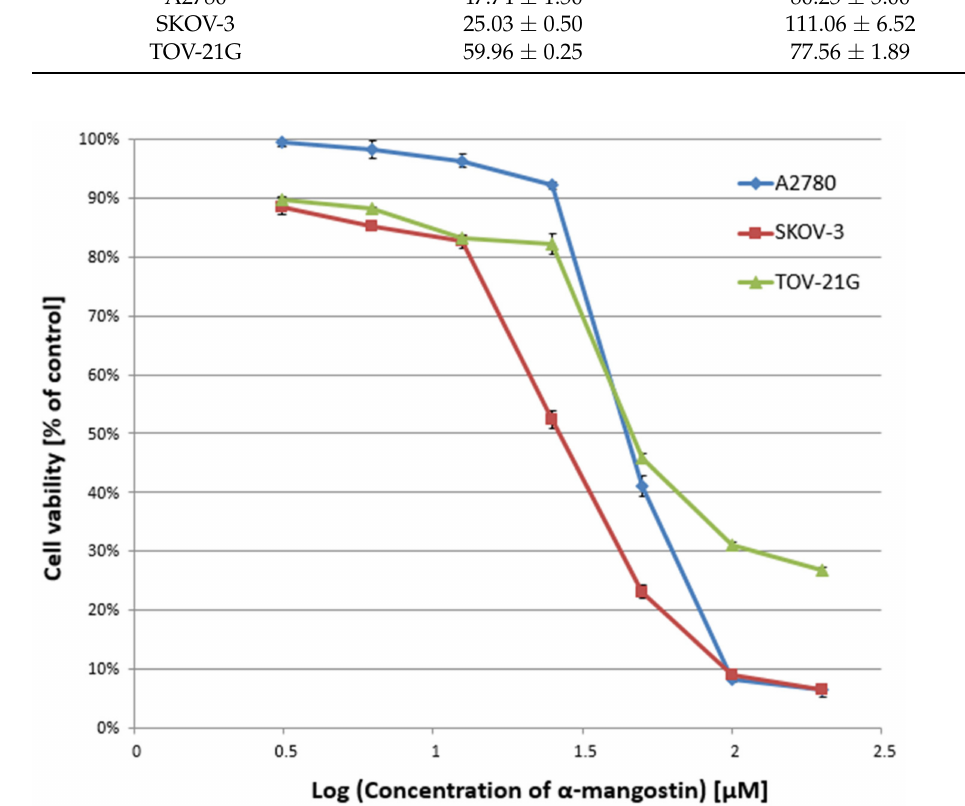
Figure 1. Effect of α -mangostin on the viability of A2780, SKOV-3, and TOV-21G human ovarian cancer cells measured by XTT assay and analyzed with ANOVA test. The cells were treated with indicated concentrations of modulators for 24 h. The data are shown as mean experiments. All of the results were statistically significant ( p < 0.001) between the cells treated with the different concentrations of modulators and the untreated control